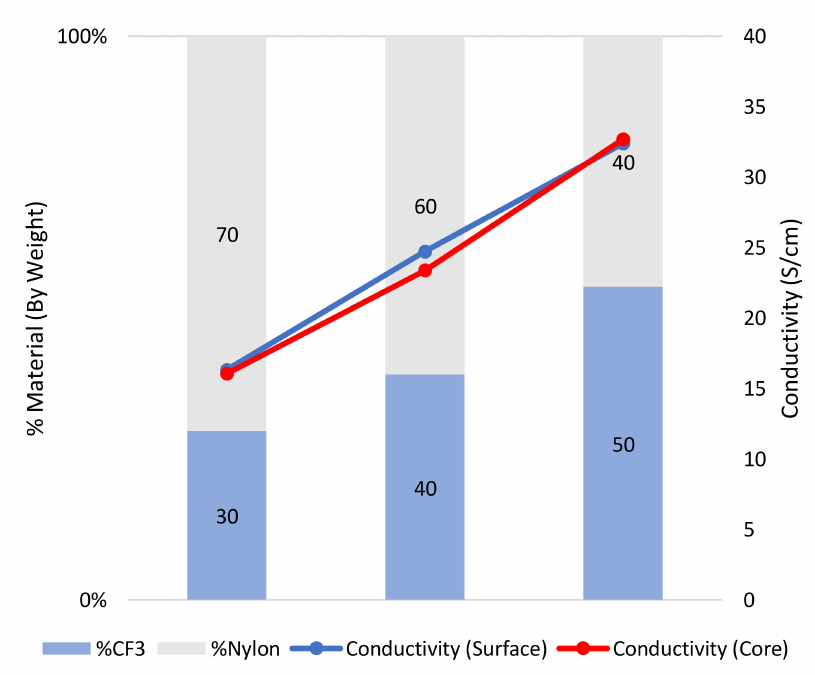
Figure 13. Comparison of core and surface conductivity of the CF3